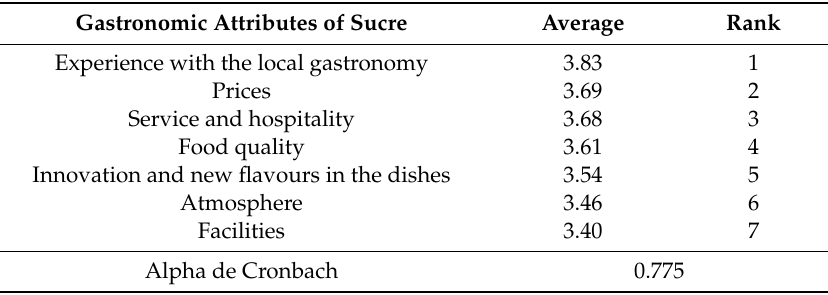
Table 4. Assessment of the attributes of the gastronomy of Sucre.